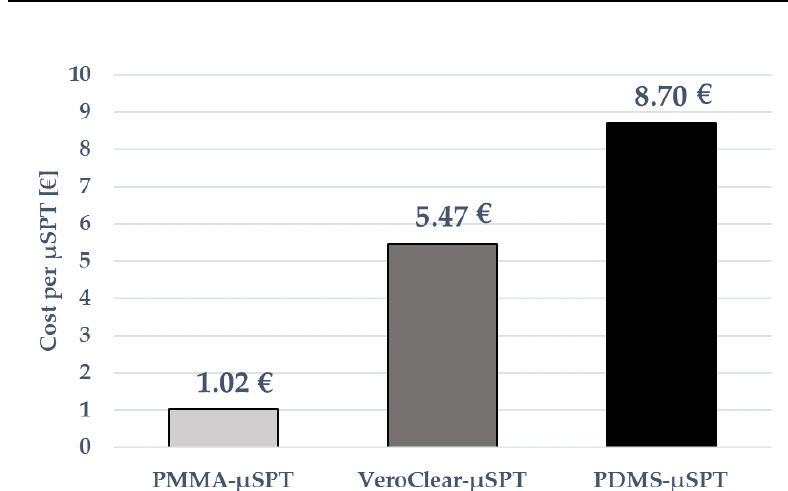
Figure 10. Evaluated final cost per unit for the PMMA- µ SPT , the VeroClear- µ SPT and the PDMS- µ SPT